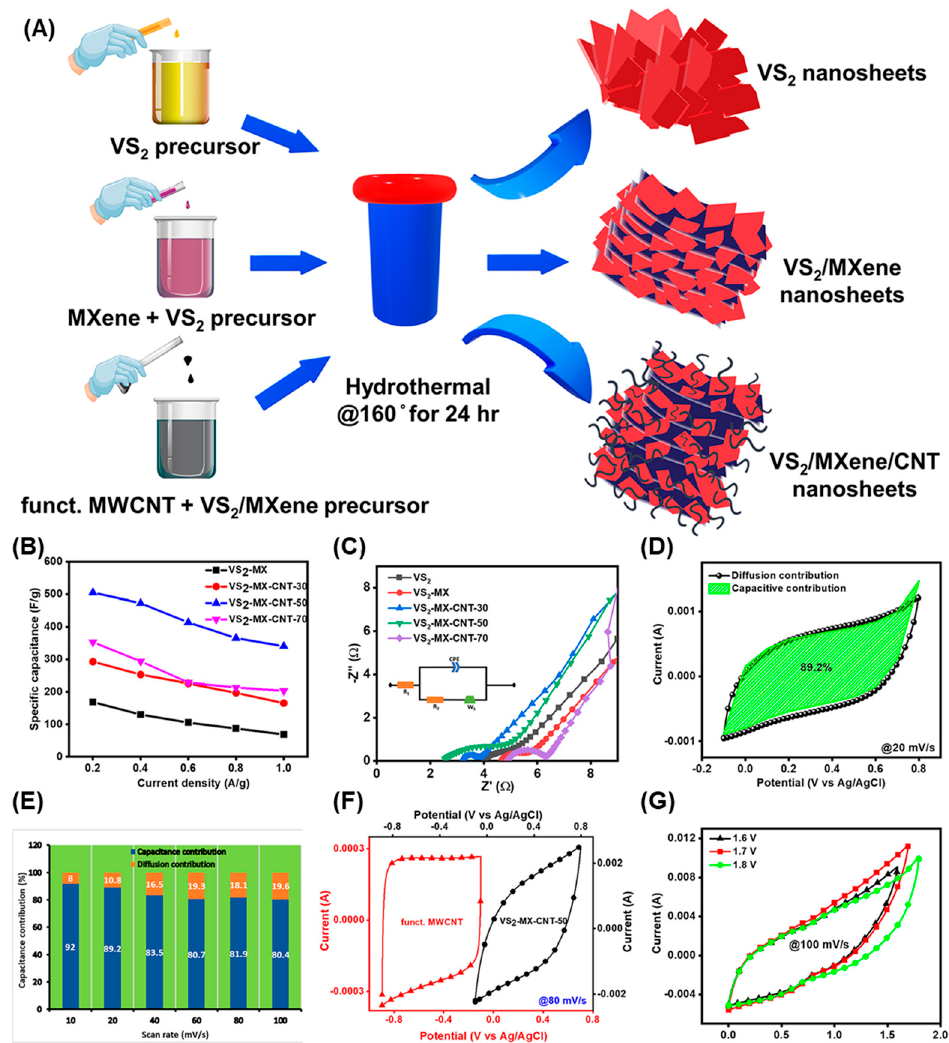
Figure 6. ( A ) General scheme of hydrothermal synthesis procedure employed to prepare VS 2, VS 2 -MX, and VS 2 -MX-CNT. ( B ) Comparison plot showing the specific capacitance of VS 2 -MX, VS 2 -MX-CNT-30, VS 2 -MX-CNT-50, and VS 2 -MX-CNT-70 samples at a current density from 0.2 A/g to 1 A/g. ( C ) Nyquist plot showing the EIS fit graphs in the circuit (see Inset). ( D ) Contribution of capacitive and diffusion-controlled areas of VS 2 -MX-CNT-50 at a scan rate of 20 mV/s. ( E ) Contribution of capacitive and diffusion-controlled reactions at scan rates ranging from 10 to 100 mV/s for VS 2 -MX-CNT-50 ternary hybrid electrode. ( F ) Comparison of MXene and VS 2 -MX-CNT-50 CV profiles at a scan rate of 80 mV/s to estimate the potential window. ( G ) The stability of potential window of VS 2 -MX-CNT-50 // MWCNT asymmetric devices from 1.6 to 1.8 V at 100 mV/s, as shown by CV curves. Reproduced with permission from ref. [42]. Copyright 2022 Wiley.